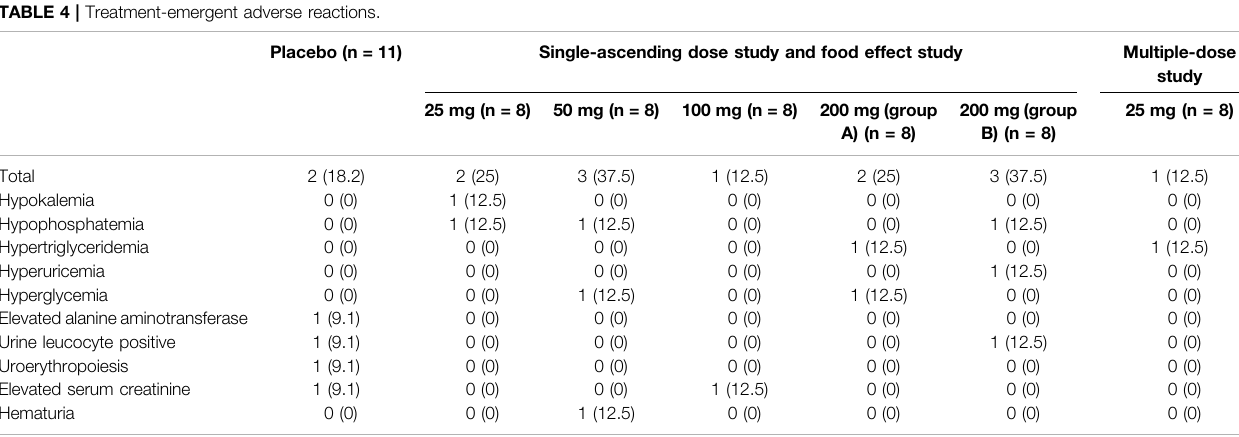
TABLE 4 | Treatment-emergent adverse reactions. Placebo (n = 11) Single-ascending dose study and food effect study Multiple-dose